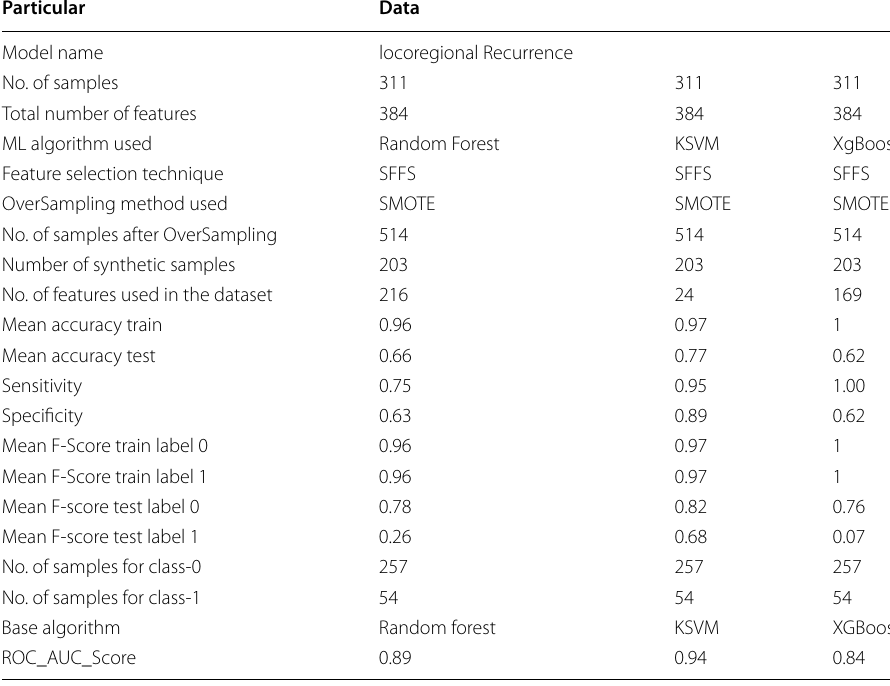
Table 8 Results of the test dataset for locoregional recurrence